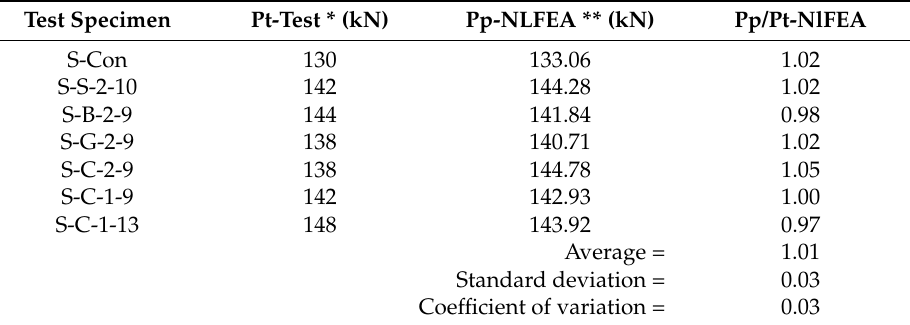
Table 5. Experimental and NLFEA prediction loading-carrying capacity.